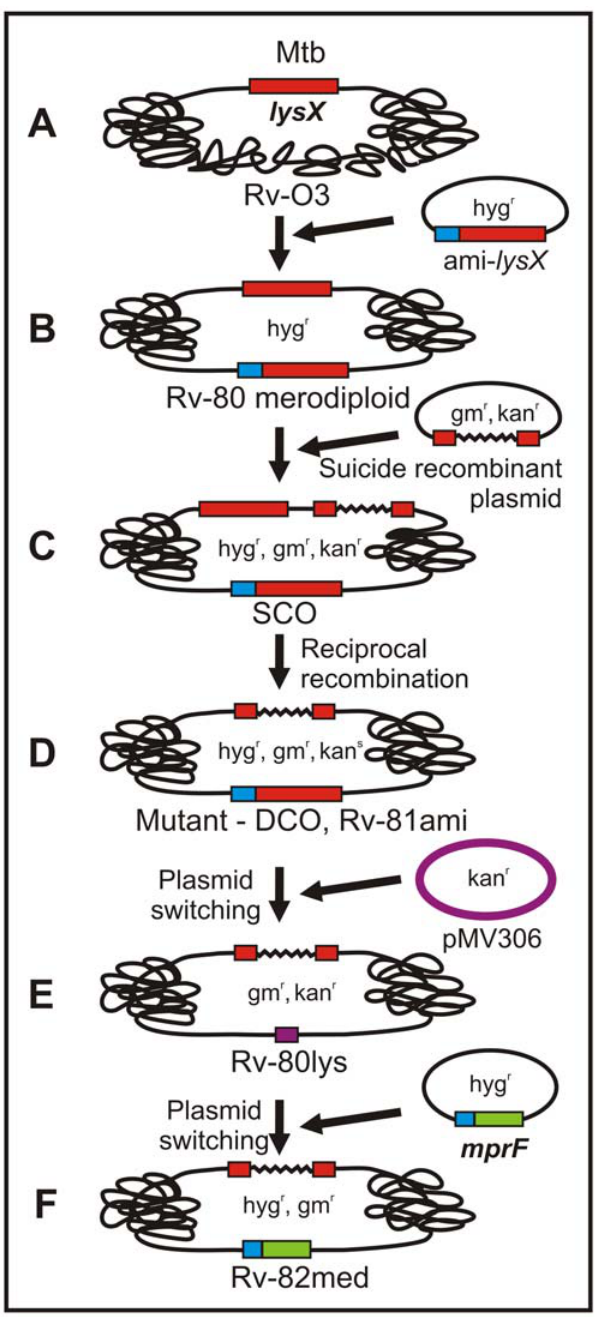
Figure 9. Cartoon showing construction of the lysX mutant and complemented strains. A- refers to the wild type strain carrying the lysX gene at its native locus. B- refers to the Rv-80 merodiploid (hyg r ) strain produced by the integration of a plasmid expressing the lysX gene from the amidase promoter. C- refers to a single crossover (SCO, hyg r , kan r , gm r ) recombinant produced by integration of the suicide recombination plasmid. D- refers to a mutant double crossover (DCO, hyg r , kan s , gm r ) produced following a reciprocal recombination event. E- refers to Rv-80lys (kan r , gm r ) produced following switching of the resident integrated plasmid (hyg r ) with the incoming pMV306 plasmid (kan r ). F- refers to Rv-82med (hyg r , gm r ) produced following switching of the resident pMV306 plasmid (kan r ) with the incoming plasmid expressing the mprF fragment from the amidase promoter (hyg r ).